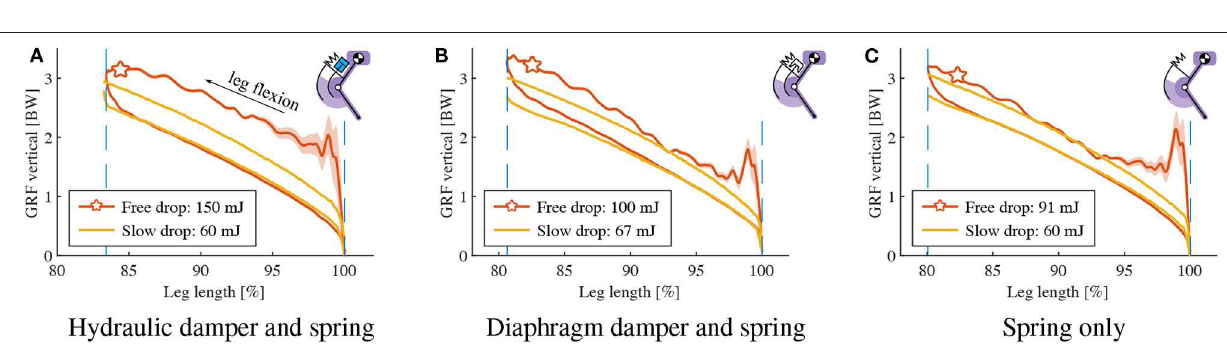
FIGURE 8 | Characterizing the contribution of velocity-dependent damping: vertical GRF vs. leg length change, a 2-DOF leg with damper/spring drops onto the force sensor: Three different hardware configurations ( A : hydraulic damper and spring, B : diaphragm damper and spring, C : spring only) were tested, for slow and free drop speeds on the vertical slider. Yellow data lines indicate slow-motion experiments. Experiments “start” bottom right, at normalized leg length 100%. Reading goes counter-clockwise, i.e., from touch-down to mid-stance is indicated by the upper part of the hysteresis curve, while the lower part indicates elastic spring-rebound, without damper contribution.